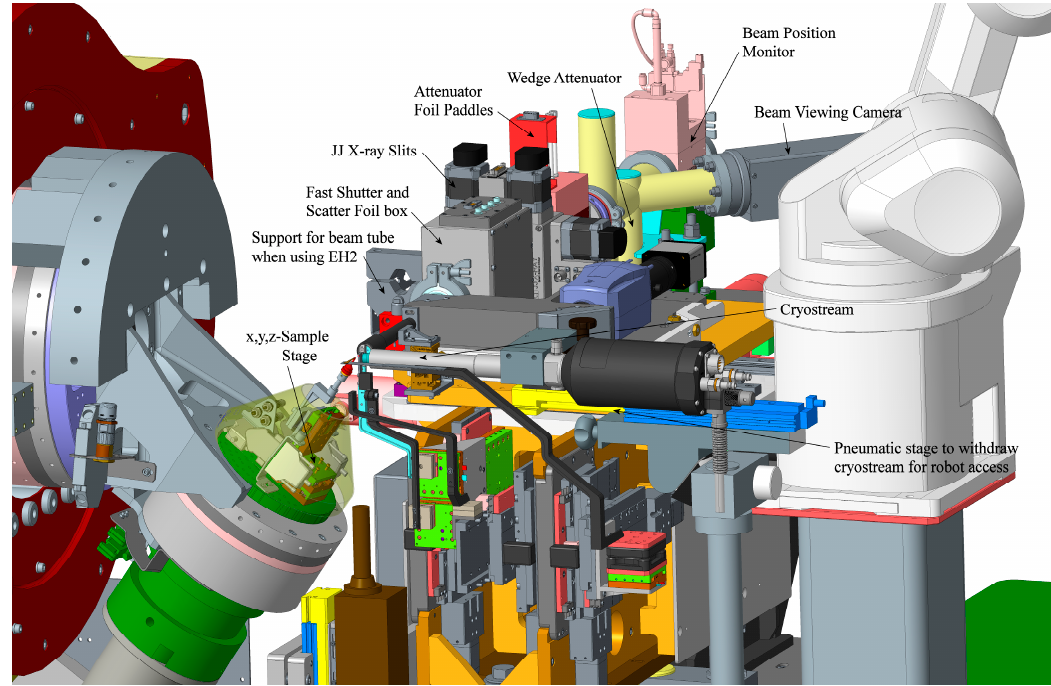
Figure 5. Detailed view of the sample stages, on-axis viewer and beam conditioning assembly. The conical cover has been shown as transparent to allow the x, y, z sample stages to be viewed. The detector has been omitted for clarity.